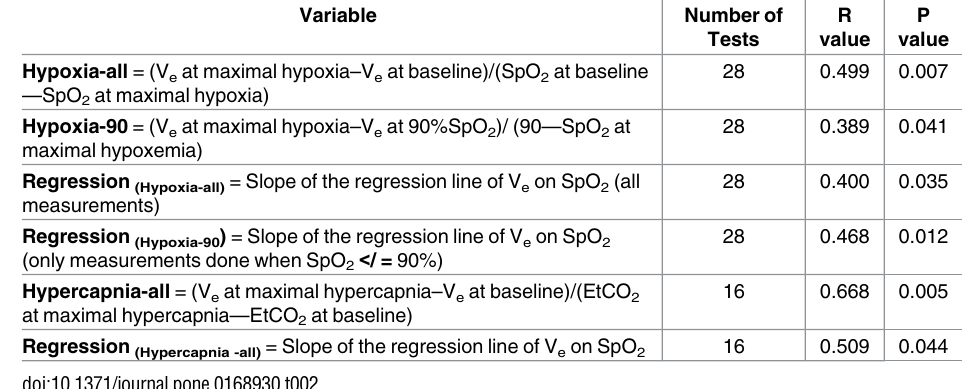
Table 2. Correlation (R- value) between test-retest using 4 different variables to expresshypoxic ven- tilatory response and 2 different variables to expresshypercapnic ventilatory response.